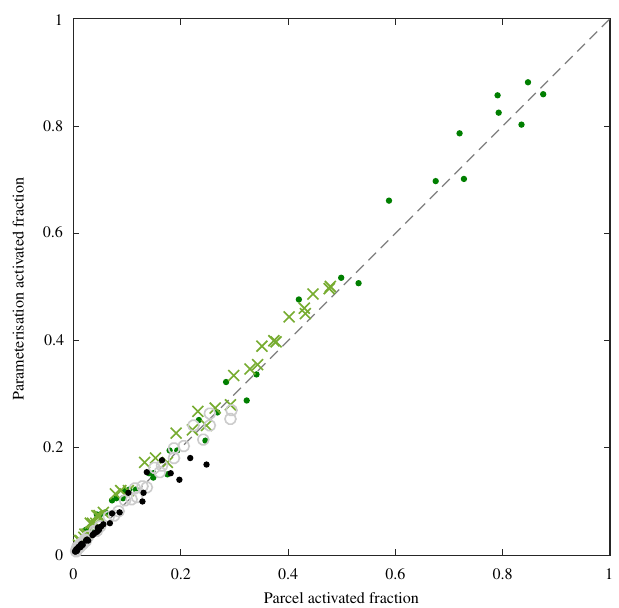
Figure 11. Scatter plot comparing the activated fractions from the parcel model against the parameterisation for the four different envi- ronments: natural (green dots), rural (green crosses), near-city (grey circles), and urban (black dots). The parcel model data are the same as the green crosses in Figs. 7 to 10 and the parameterisation data have been interpolated onto the same wind speeds as the parcel model. The 1 : 1 line is shown by the grey dashed